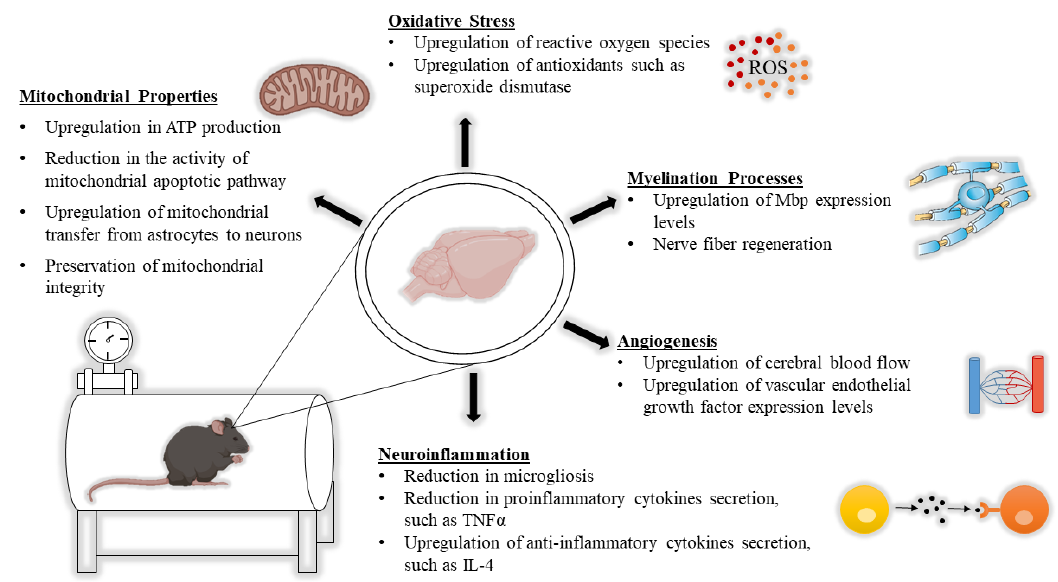
Figure 1. Key molecular changes in the brain following hyperbaric oxygen therapy (HBOT). Mitochondrial properties, oxidative stress, myelination processes, angiogenesis, and neuroinflammation are all altered following HBOT.